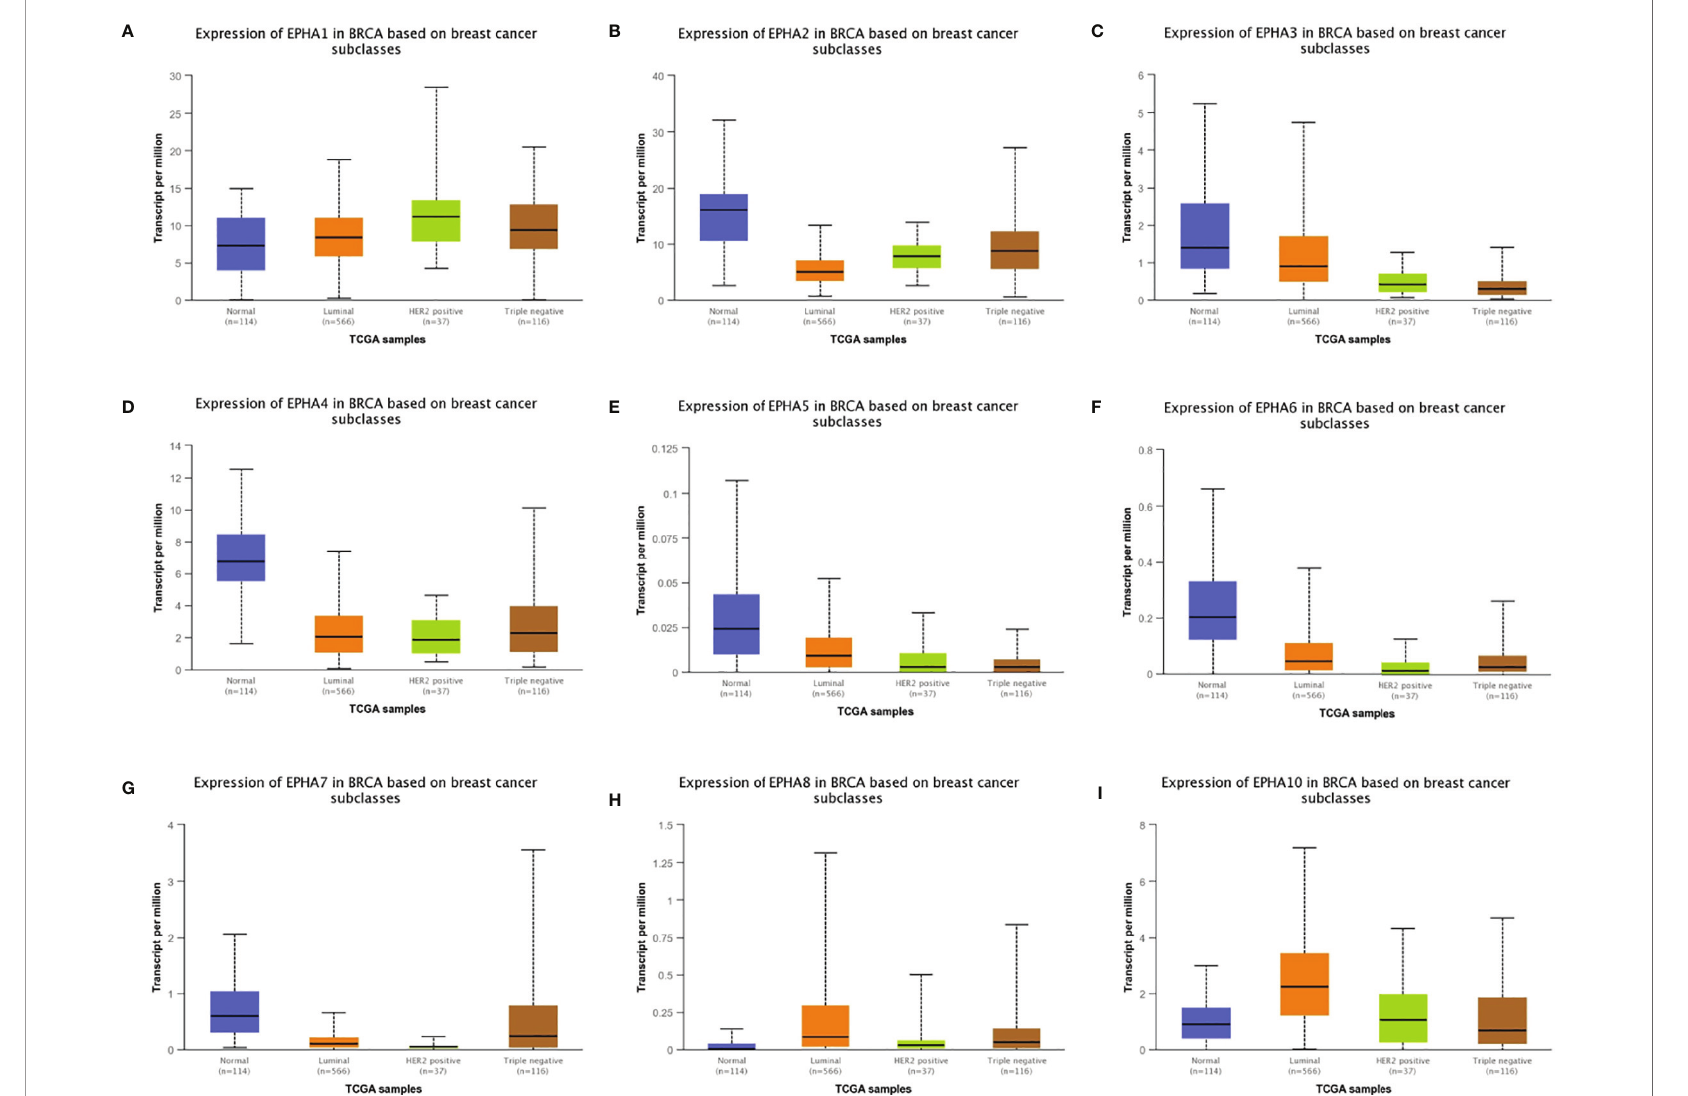
FIGURE 3 | The correlation between EphA family expression and molecular subtyping in breast cancer patients. The graphs produced from the UALCAN database showed the expression of EphA family genes in different molecular subtyping of breast cancer. The normal tissues were shown in red, the liminal types were shown in orange, the Her2-positive type were shown in green and the triple negative type were showed in brown. The EphA family genes include (A) EphA1; (B) EphA2; (C) EphA3; (D) EphA4; (E) EphA5; (F) EphA6; (G) EphA7; (H) EphA8; (I)